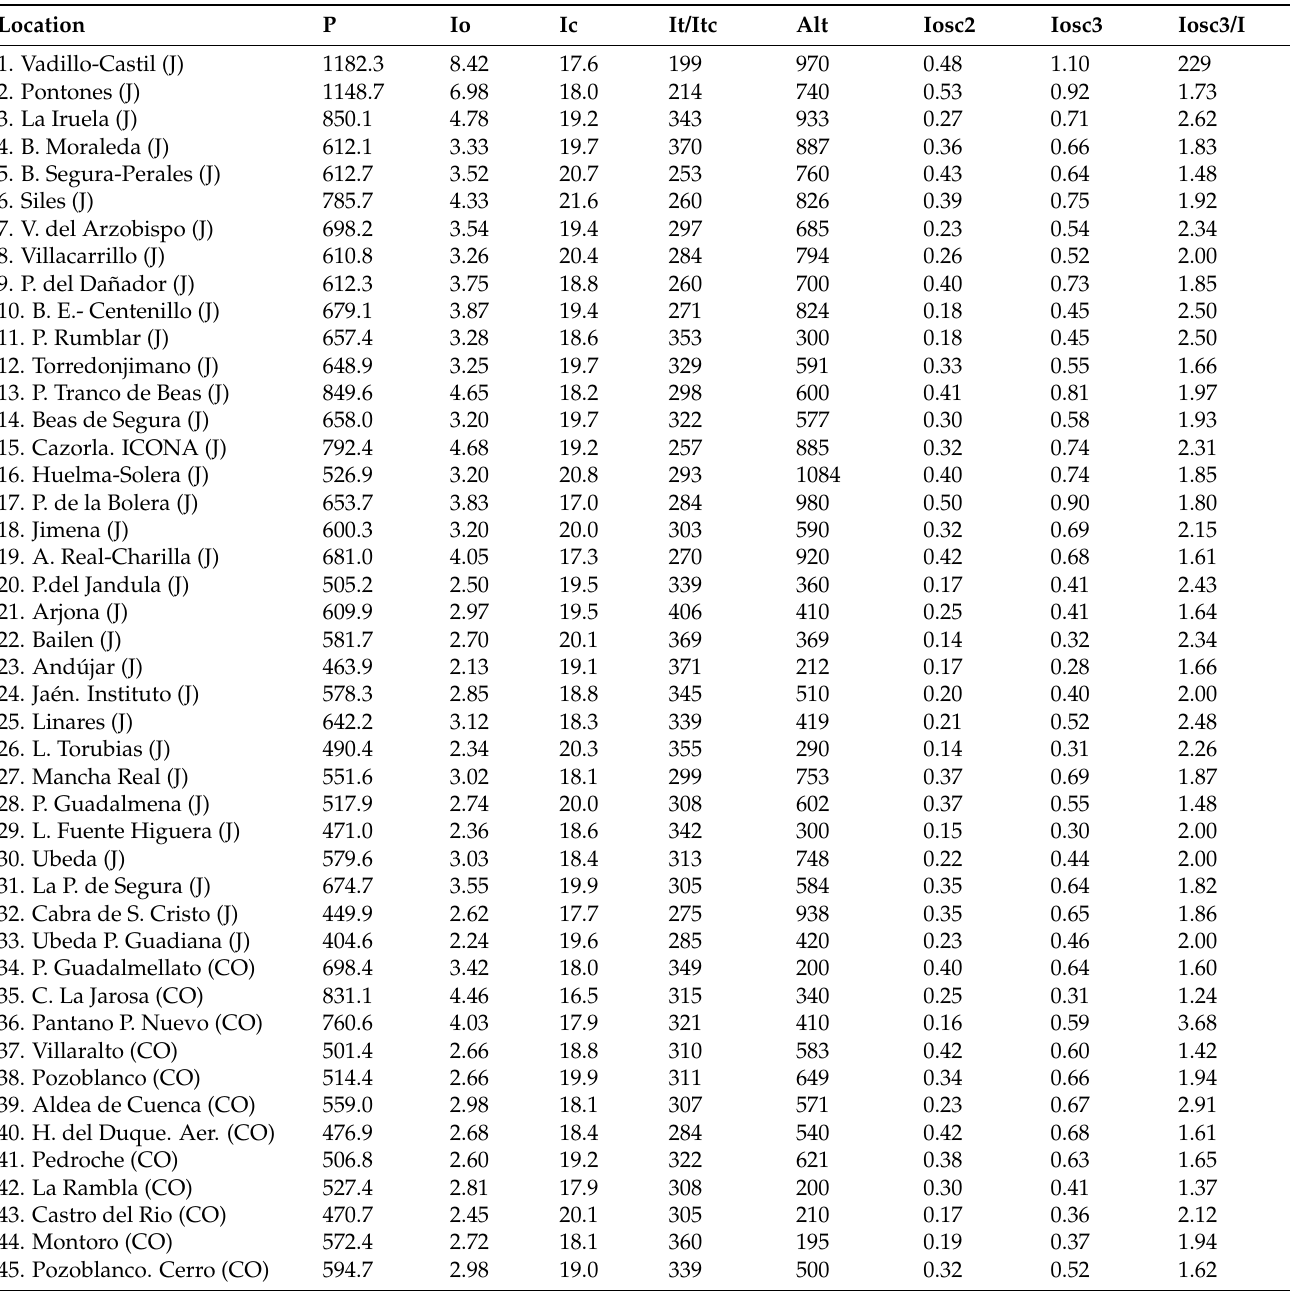
Table 1. Values of bioclimatic indices for the southern Iberian Peninsula (Andalusia). P.